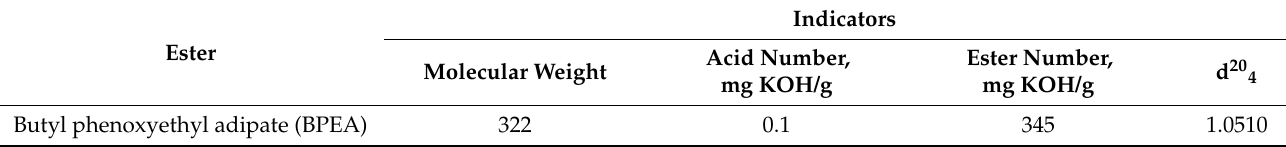
Table 1. Physicochemical properties of butyl phenoxyethyl adipate .